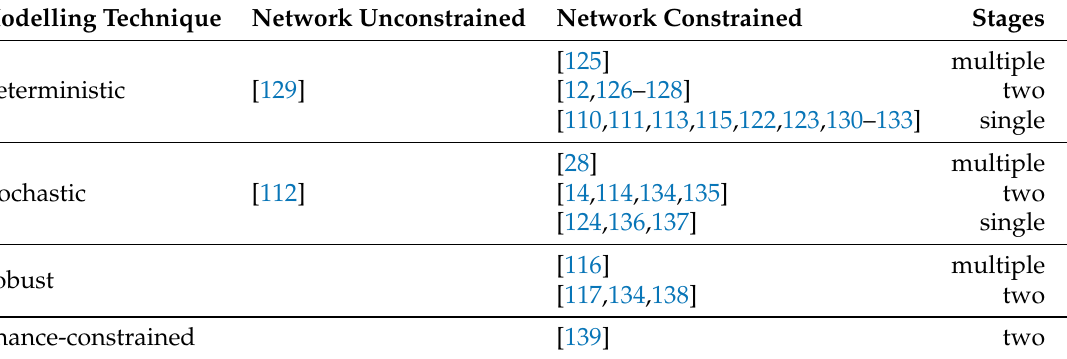
Table 4. Literature survey on the ESS investment planning models at the transmission